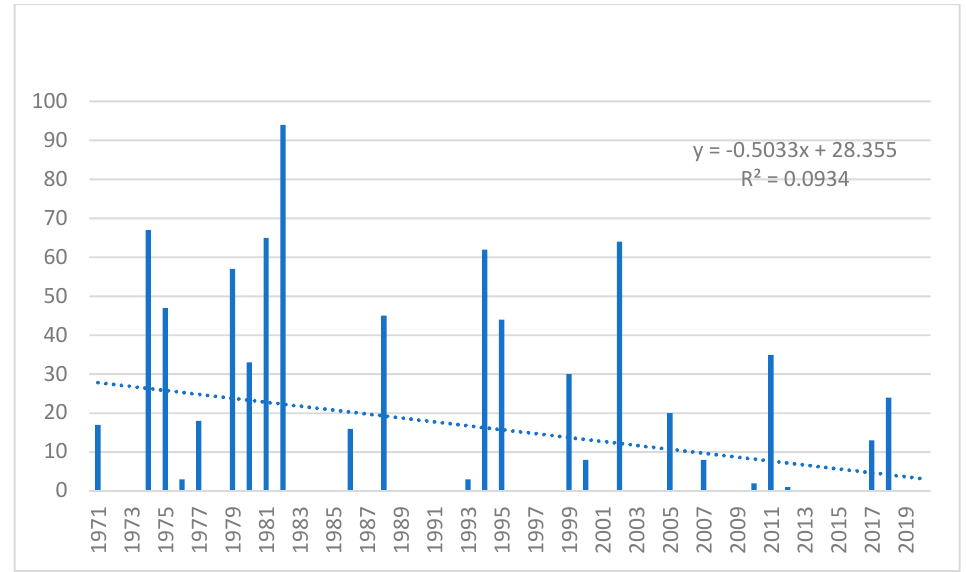
Figure 9. The number of days with discharge levels above SWQ (days with floods) in the period 1971–2020.